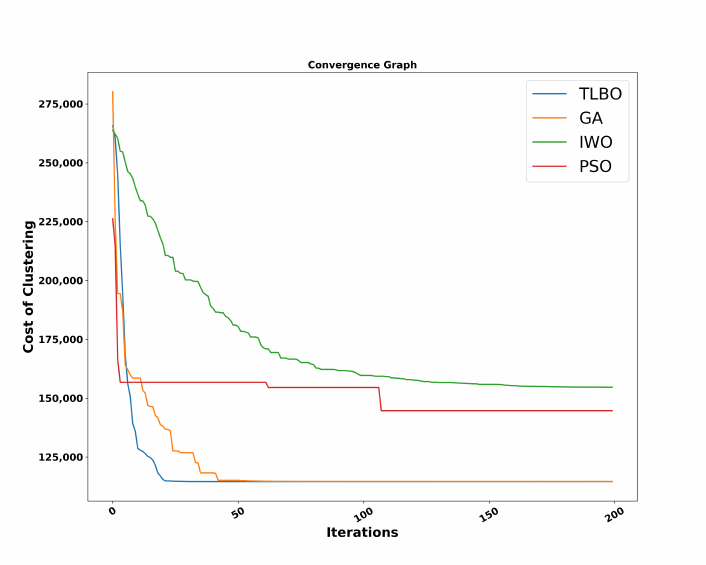
Figure 4. Cost of clustering graph of each algorithm to show convergence up to 200